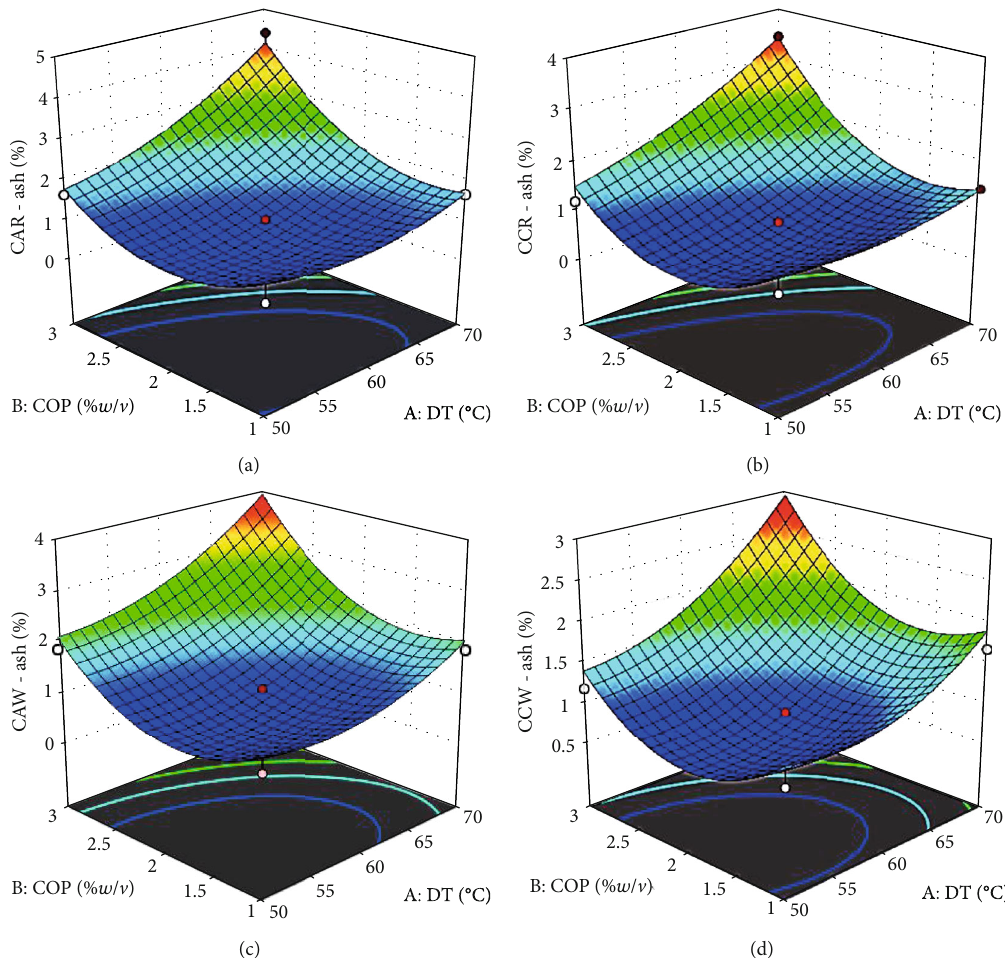
Figure 2: Response surface plots for ash content of cassava fl our. (a) Cassava from red landrace pretreated with citric acid. (b) Cassava from red landrace pretreated with calcium chloride. (c) Cassava from white landrace pretreated with citric acid. (d) Cassava from white landrace pretreated with calcium chloride. DT — drying temperature ( ° C); COP — concentration of pretreatment (% w / v